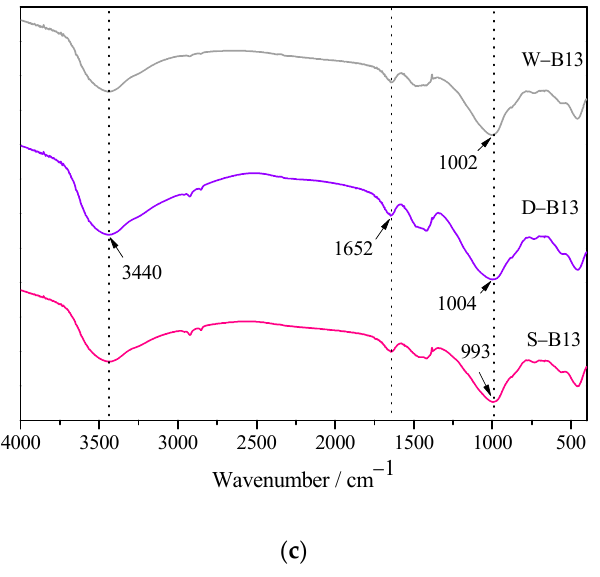
Figure 6. FT-IR spectra of AA-FASM under the different curing conditions. ( a ) Seal curing. ( b ) Dry and water-saturation curing. ( c )